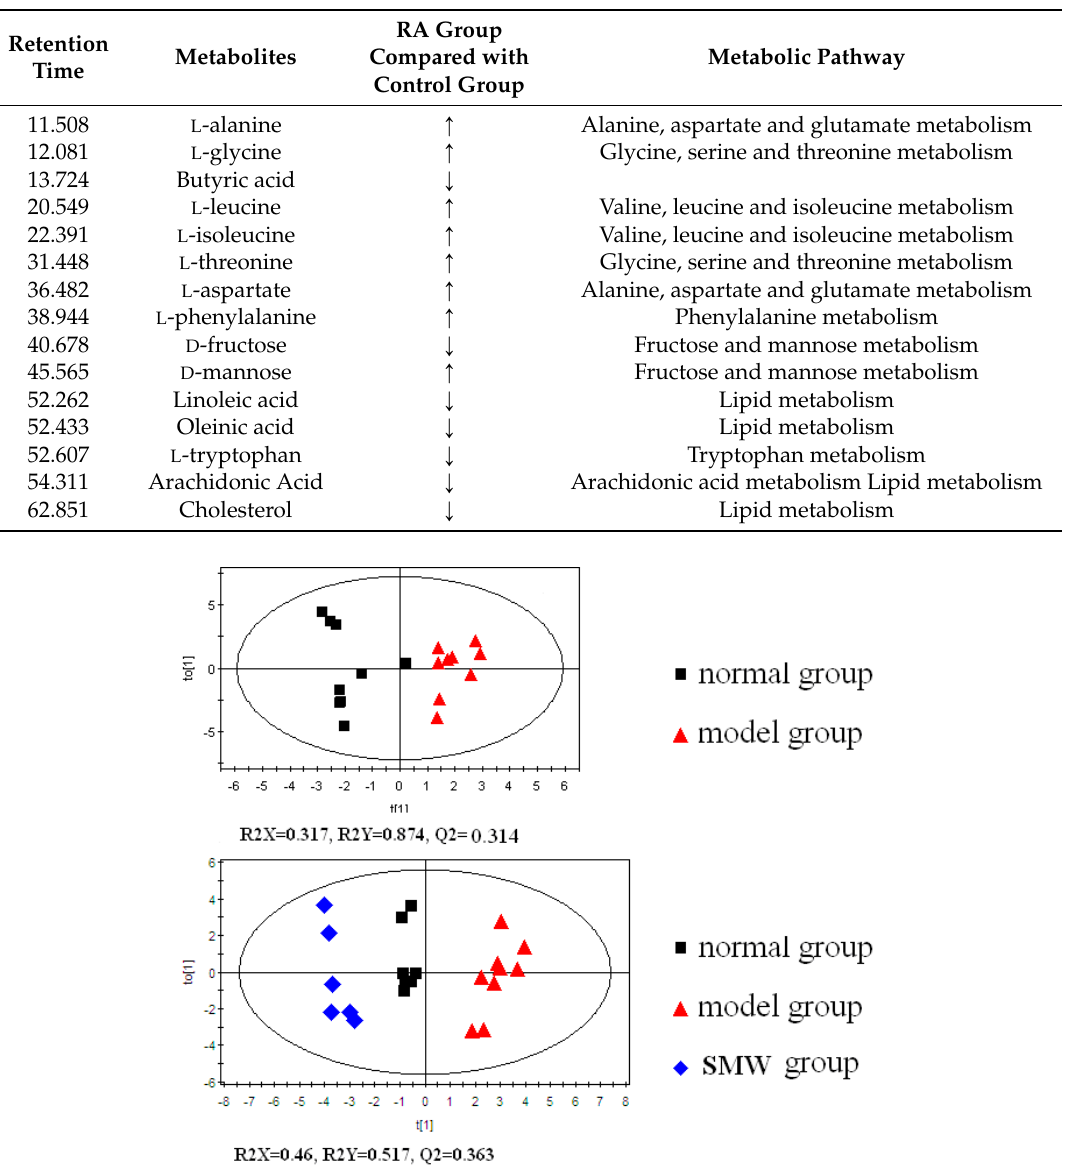
Table 2. Metabolites of variable importance for projection (VIP) > 1 in normal group and model group.